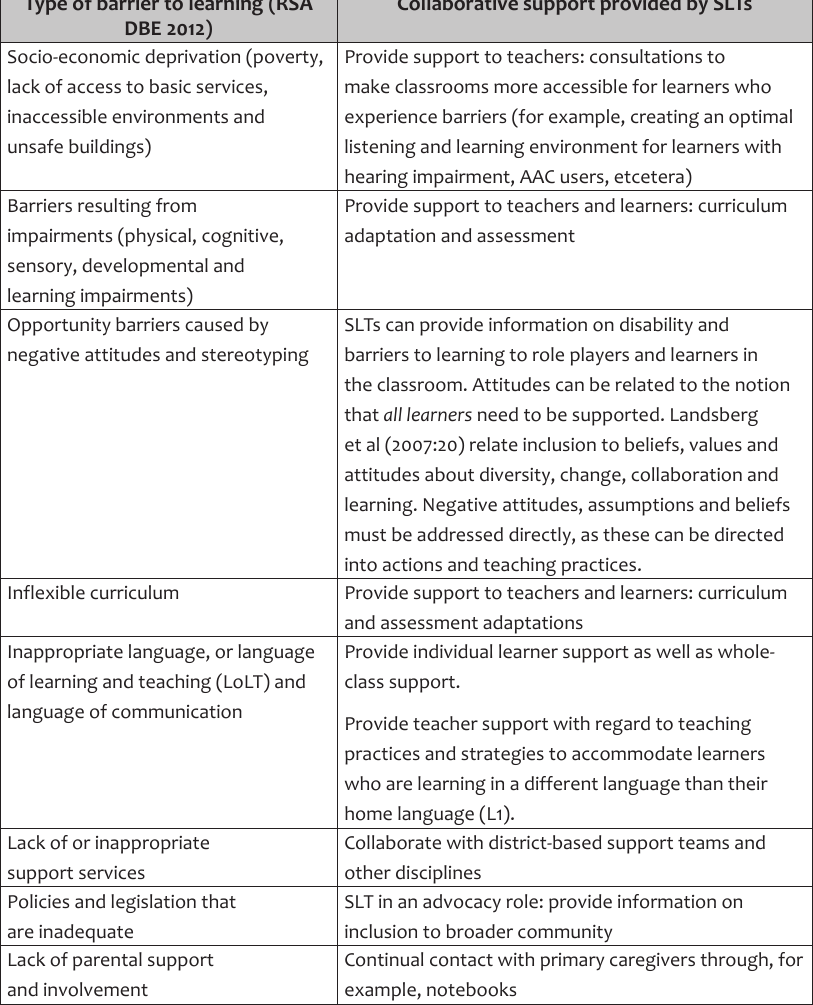
Table 2: Collaborative support to teachers by SLTs within inclusive education Type of barrier to learning (RSA DBE